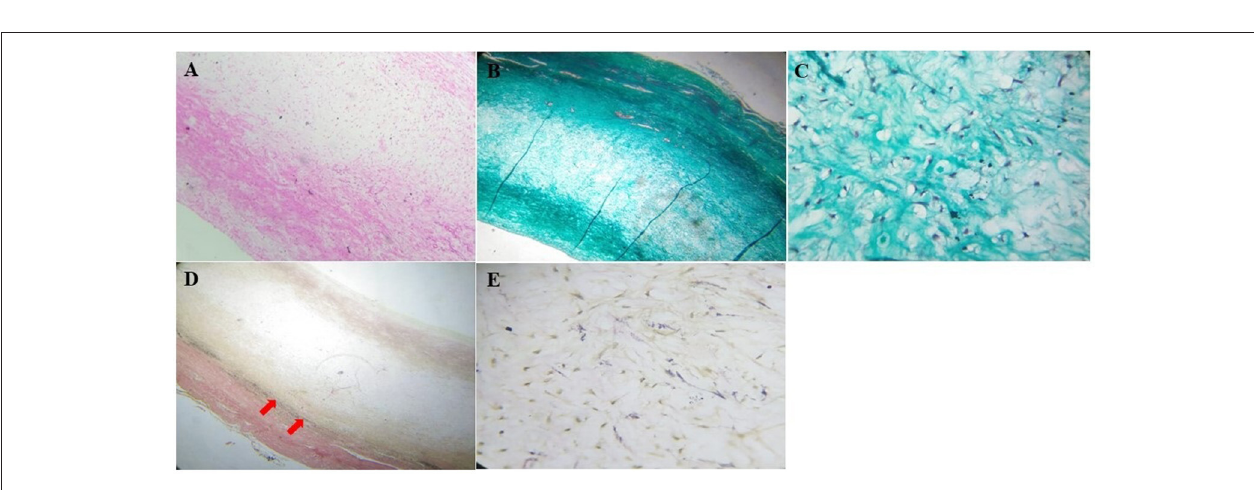
FIGURE 4 | Histopathological assessment of the resected aorta. (A) The wall of the aorta stained with hematoxylin and eosin stain showed thickened tunica media with myxoid change (100x). (B) Masson’s trichome staining showed disorganization and fragmentation of collagen (40x) with, (C) an increase in fibroblasts in the tunica media (400x). (D) Verhoeff-van Gieson stain showed deficient and fragmented elastic fibers (red arrows, 40x), with (E) increased fibroblasts